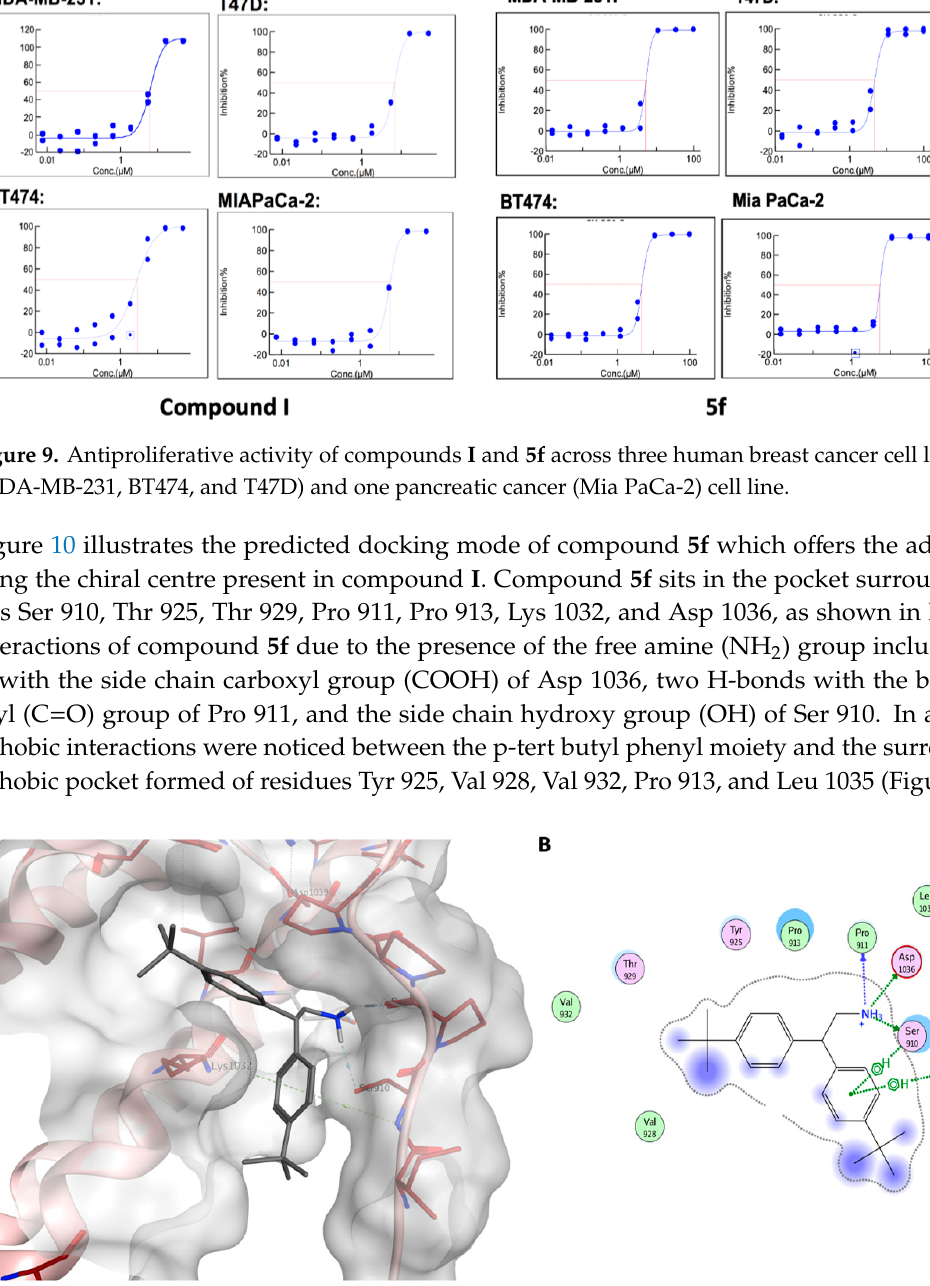
Figure 10. ( A ) The predicted binding mode of compound 5f inside the pocket of the FAK-FAT domain showing hydrogen bonds as blue dashed lines. ( B ) The detailed interactions between compound 5f and FAK-FAT domain.